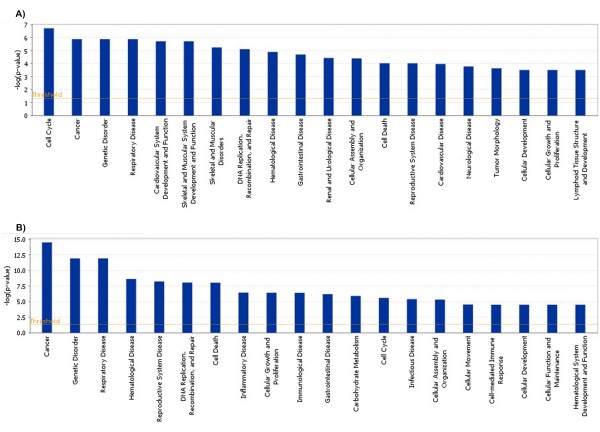
The top 20 most significant biological functions identified from the Imd0/Nvd0 and Imd2/Imd0 datasets from Expt. 2, using Ingenuity Pathways Analysis software (Ingenuity® Systems, [26]). The Functional Analysis identified the biological functions and/or diseases that were most significant to the data set. Right-tailed Fisher's exact test was used to calculate a P-value determining the probability that each biological function and/or disease assigned to that data set is due to chance alone.